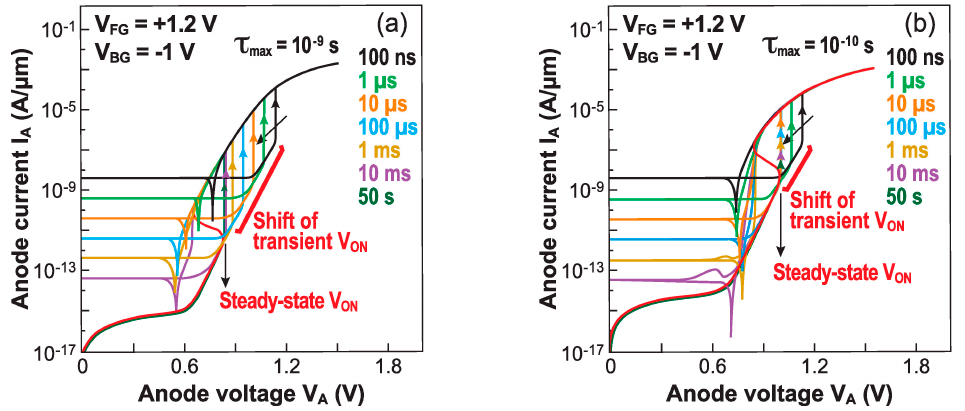
Figure 6. I A -V A characteristics of Z 2 –FET for different ramp times (100 ns to 50 s) of anode voltage, from zero to 2 V. The carrier lifetime is ( a ) τ = 10 − 9 s and ( b ) 10 − 10 s. The two wells were filled with carriers by gate pulses before ramping V A (adapted from [25]).